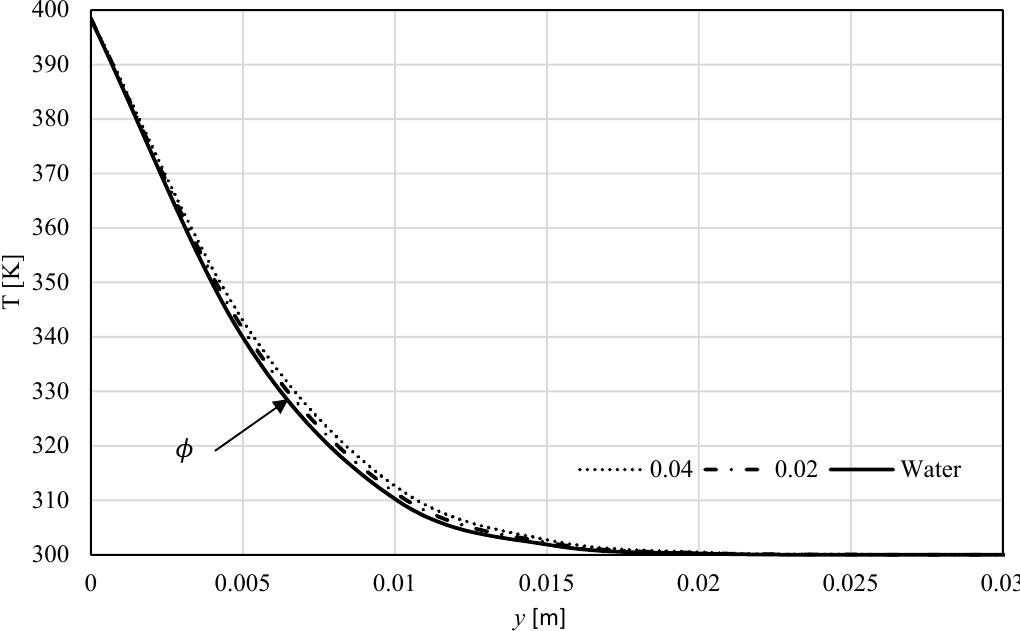
Figure 9. Temperatures profiles perpendicular to the sheet for Al 2 O 3 –water nanofluid at different volume fractions 𝜙 .